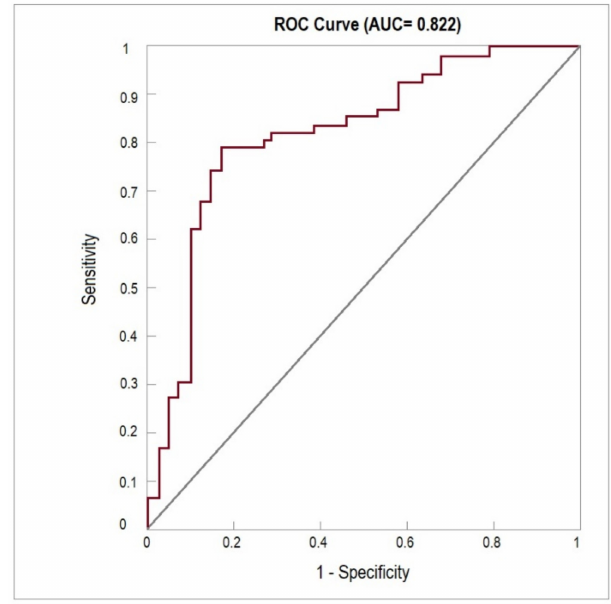
Figure 5. ROC curve for the validation